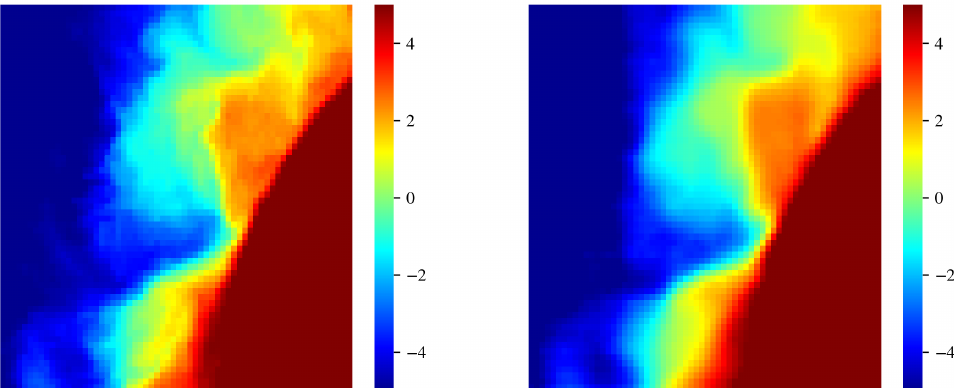
Figure 3. ( left ) Input cutout, preprocessed as described in Section 3.1. ( right ) Image generated by the trained autoencoder, which passed the cutout through a 512 unit latent space. As designed, the reproduction captured the gross features but not all of the small-scale